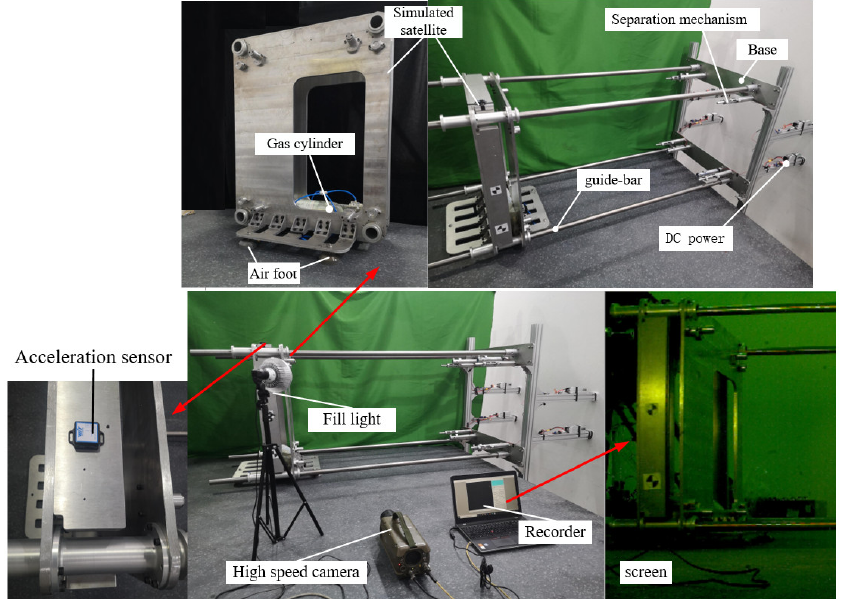
Figure 19. Separation velocity test.